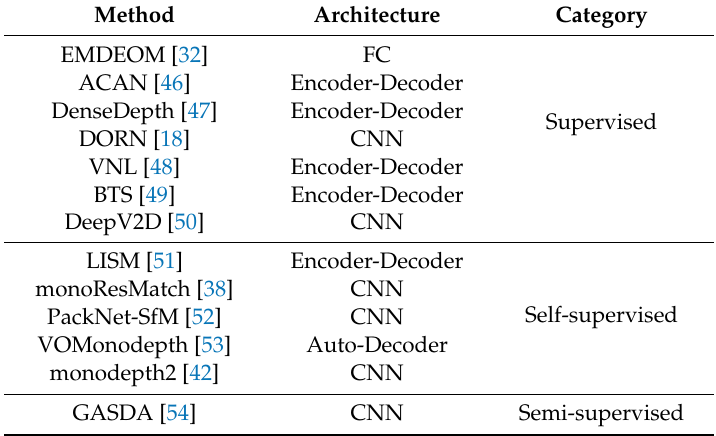
Categories of deep learning-based monocular depth estimation methods (FC: fully convolutional; CNN: convolutional neural networks). Method